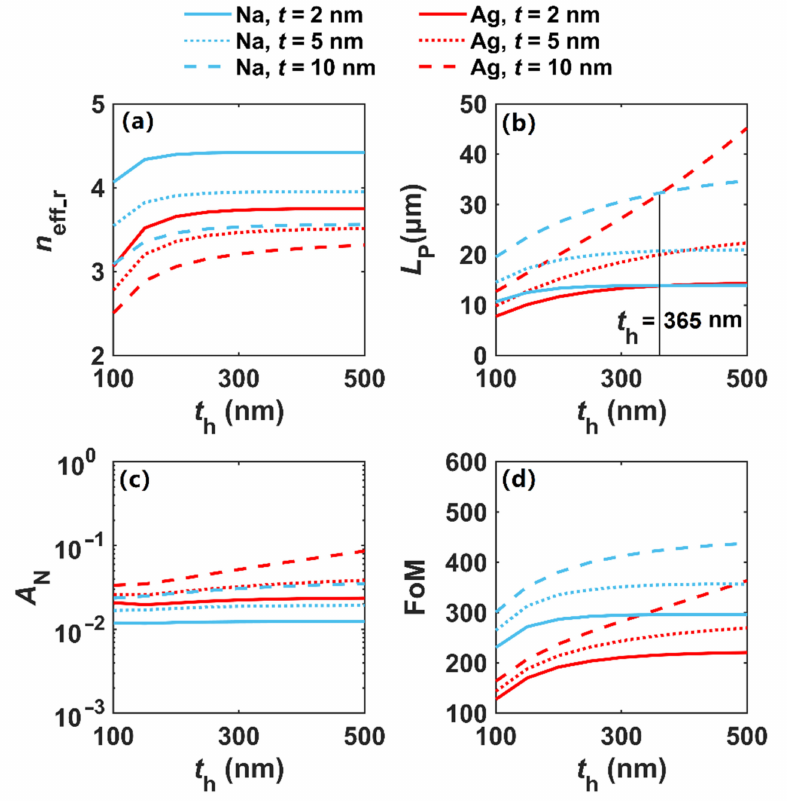
Figure 9. Modal properties of DDCMNWs based on Na and Ag with different cladding thickness t h at λ = 1500 nm. ( a ) n eff_r , ( b ) L P , ( c ) A N , ( d ) FoM. Thicknesses of SiO 2 are set to be t = 2, 5, 10 nm and r = 100